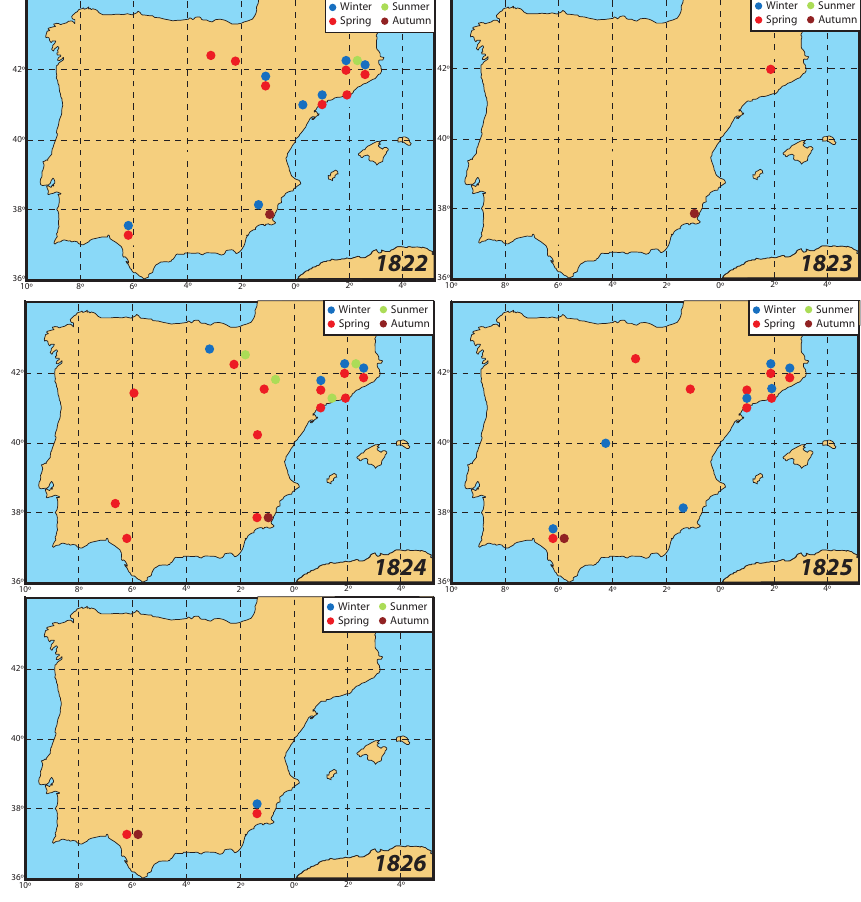
Fig. 8. Geographical distribution of rogations celebrated in Spain between 1822 and